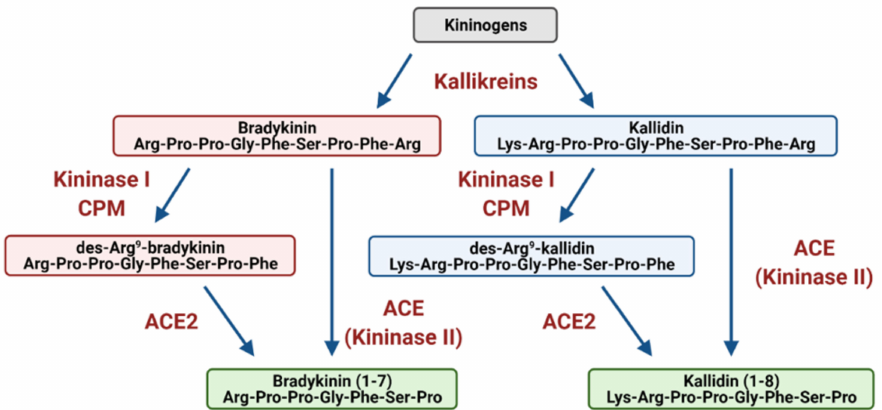
Figure 3. The Kallikrein–Kinin/Bradykinin System. Kallikrein serine proteases cleave kininogens to release the vasoactive peptides bradykinin (BK) and kallidin (KD). The peptidase Kininase I (carboxypeptidase M, CPM) further cleaves BK and KD into the active des-Arg 9 -bradykinin (DABK) and des-Arg 10 -kallidin (DAKD). Kininase II or ACE, inactivates the KKS by degrading BK, KD, DABK and DAKD into inactive metabolites. Similarly, ACE2 metabolizes DABK to BK (1-7) and DAKD to KD (1-8) [79] (created with